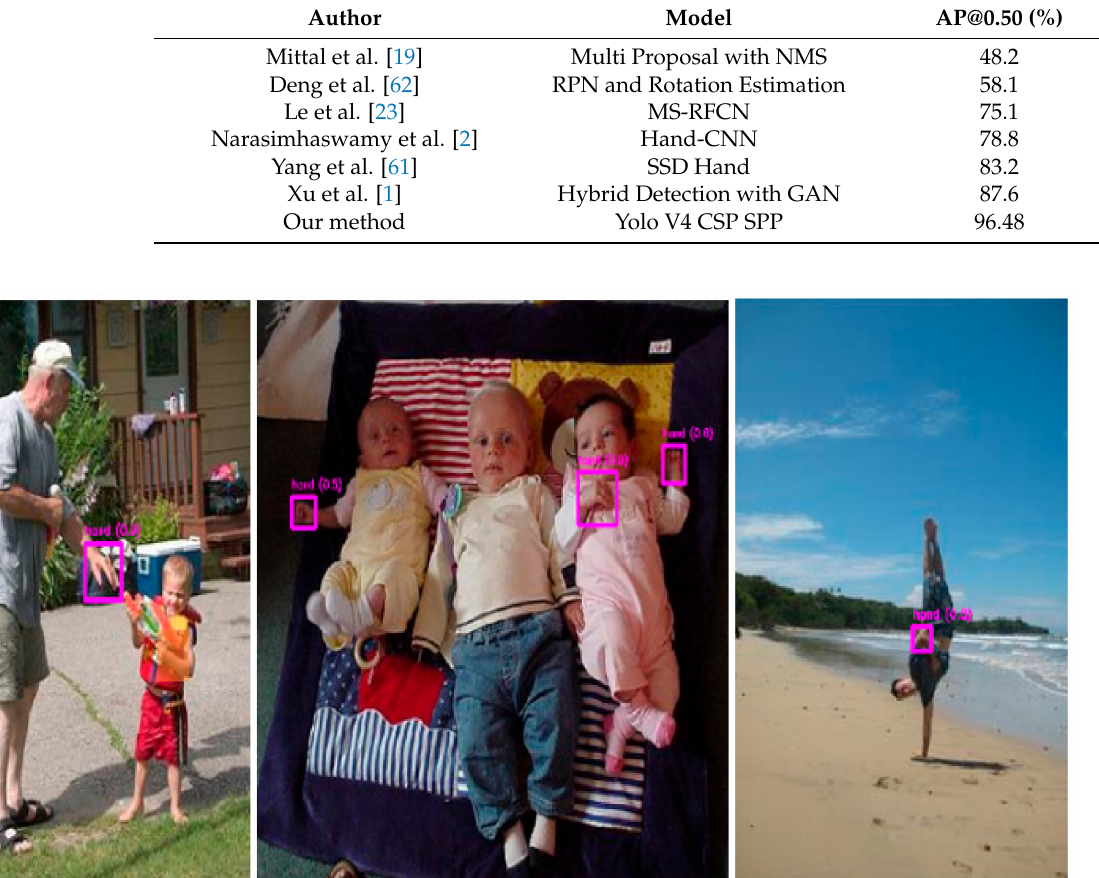
Table 4. Comparison of the performance of various methods for Oxford hand dataset detection.